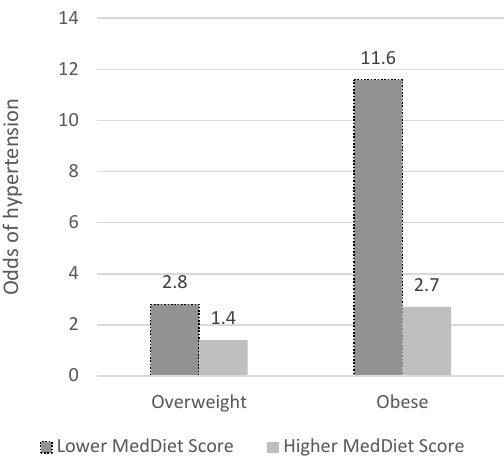
Figure 3. Odds of hypertension among overweight and obese participants compared to healthy weight, by MedDiet score. Chi square test for di ff erences p < 0.001, Results based on multiple logistic regression: Fully adjusted for age, sex, sodium intake ( > 1500 mg / day vs. ≤ 1500 mg / day), employment status, educational and activity level, hyperlipidemia (presence of high cholesterol and / or triglycerides), and diabetes; Lower MedDiet Score < 23; Higher MedDiet Score ≥ 23.